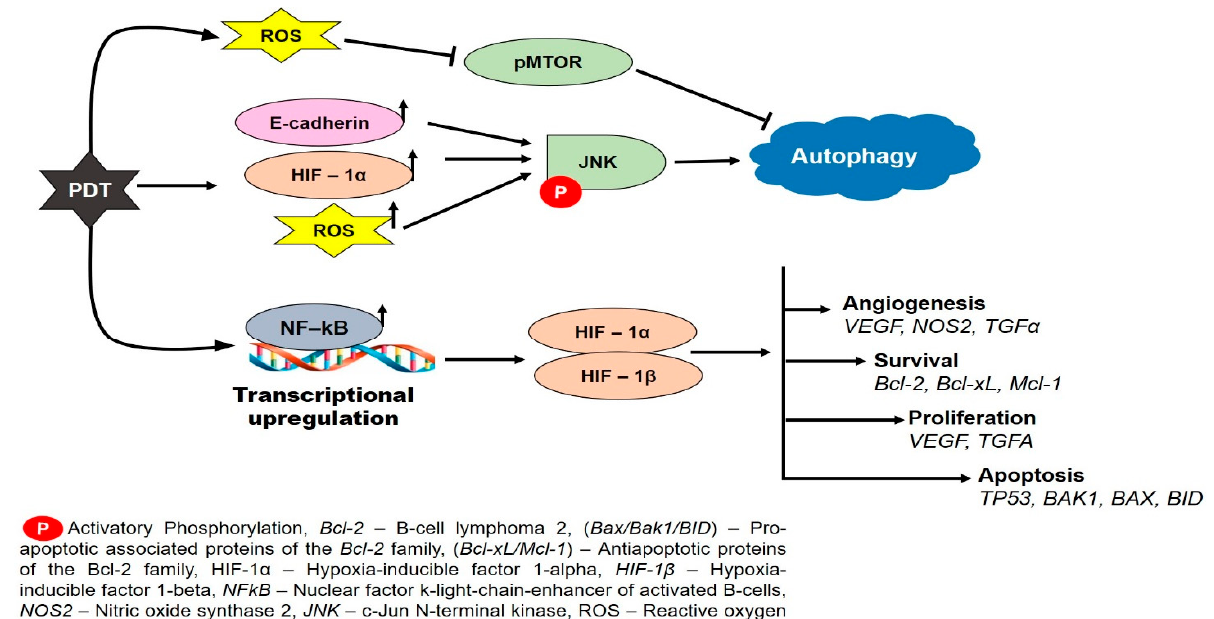
Figure 2. PDT-induced autophagy and resistance in hypoxic tumor. PDT is exacerbated by high levels of ROS, HIF-1 α , and E-cadherin to activates c-Jun N-terminal kinase and cellular processes of autophagy. Alternatively, PDT in hypoxic tumor upregulates NF-kB to cause the stabilization of HIF-1 proteins and expression of angiogenic, surviving, proliferating signals that causes tumor relapse or apoptotic signal that kills the cell.